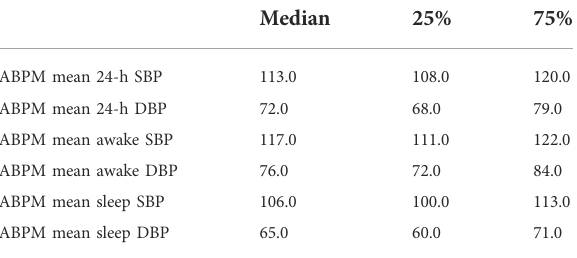
TABLE 1 Description of ABPM results ( n = 281).